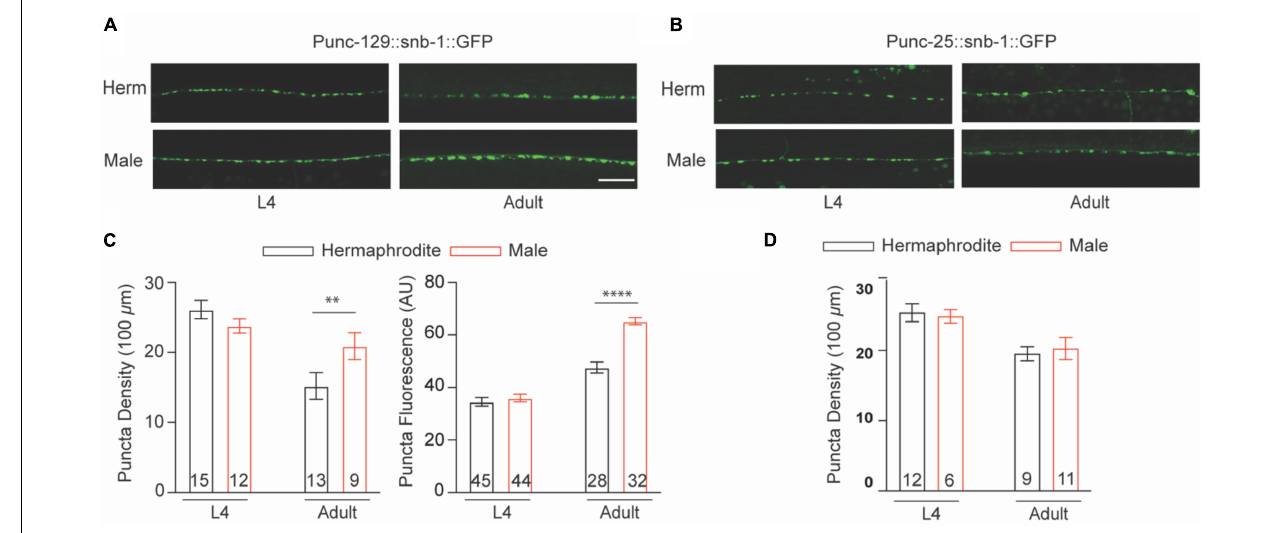
FIGURE 2 | Cholinergic NMJs exhibit sex-specific difference in adult C. elegans . The distribution of Punc-129:SNB-1:GFP (A) and Punc-25:SNB-1:GFP (B) at NMJs of males and hermaphrodites at the larval stage L4 and adult stage. (C) Bar graph summarizing the Punc-129:SNB-1:GFP puncta density and fluorescence from males and hermaphrodites. (D) Bar graph summarizing the Punc-25:SNB-1:GFP puncta density from males and hermaphrodites. Sample sizes ( n numbers) are indicated in the bars of each graph. All data are represented as mean ± SEM ( ∗∗ p < 0.01, ∗∗∗∗ p < 0.0001, t